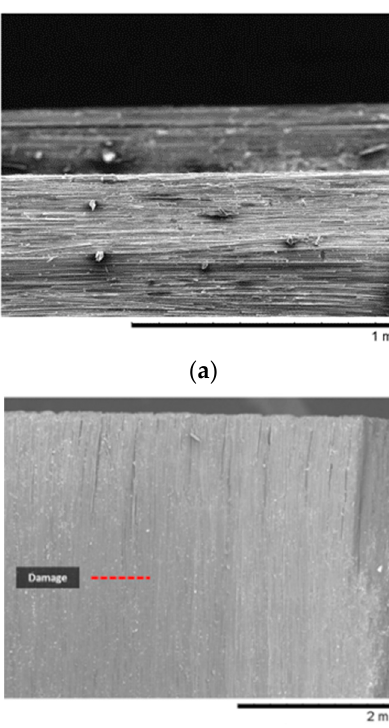
Figure 13. The combined effect of depth of cut and fibre orientation and on damage depth for 10°